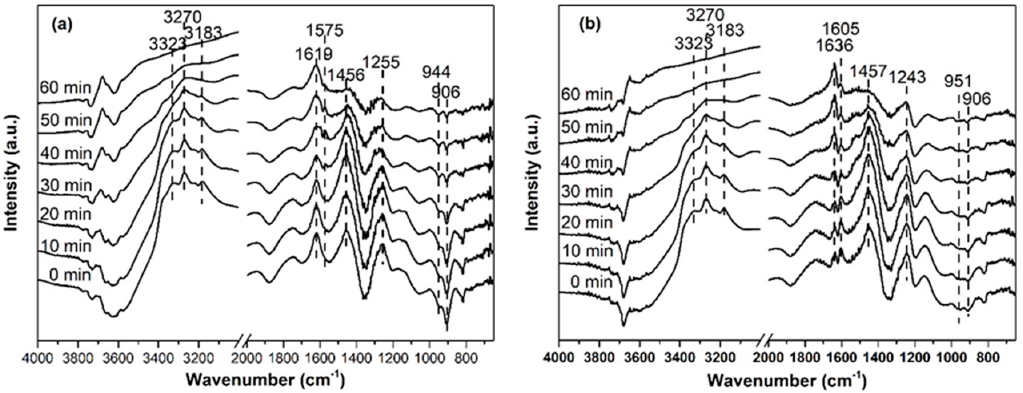
Figure 6. In situ DRIFTS spectra of ( a ) Cu-SSZ-13 and ( b ) 5% Mn/Cu-SSZ-13. Catalysts were exposed to 1000 ppm NH 3 /N 2 until saturated and then purged by N 2 to remove weakly absorbed NH 3 . 1000 ppm NO/N 2 and 5% O 2 were injected starting at 0 min.